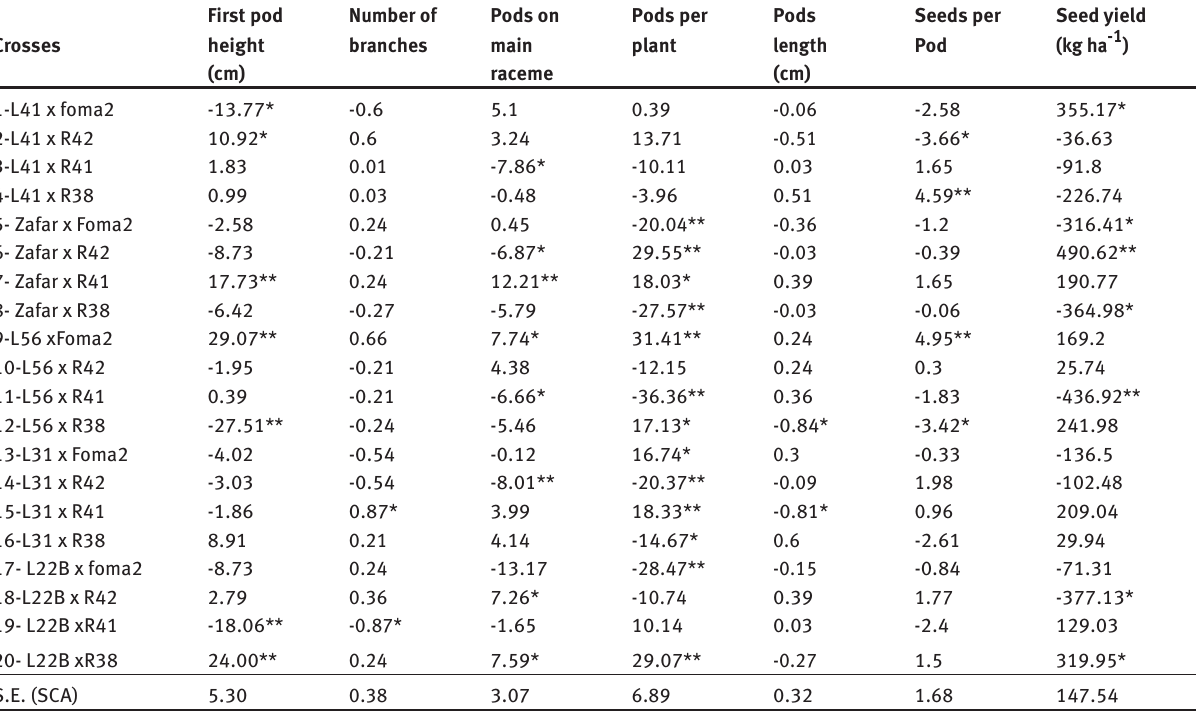
First pod Number of Pods on Pods per Pods Seeds per Seed yield Crosses